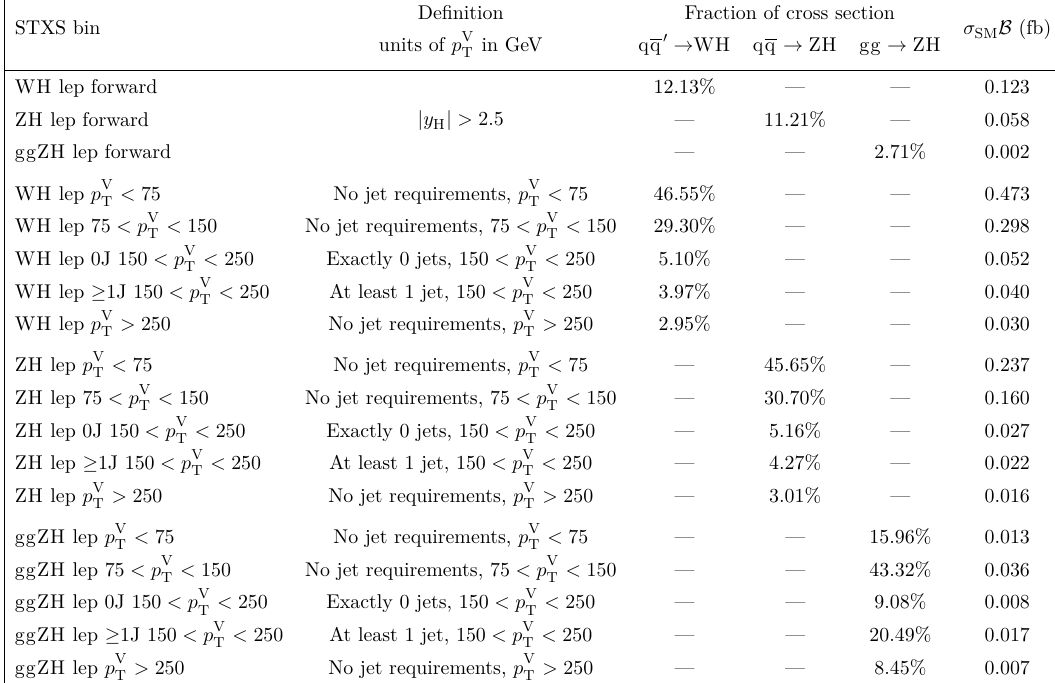
Table 6 . Definition of the VH leptonic STXS bins. The product of the cross section and branching √ fraction ( B ), evaluated at = 125 GeV, is given for each bin in the last s = 13 TeV and m H